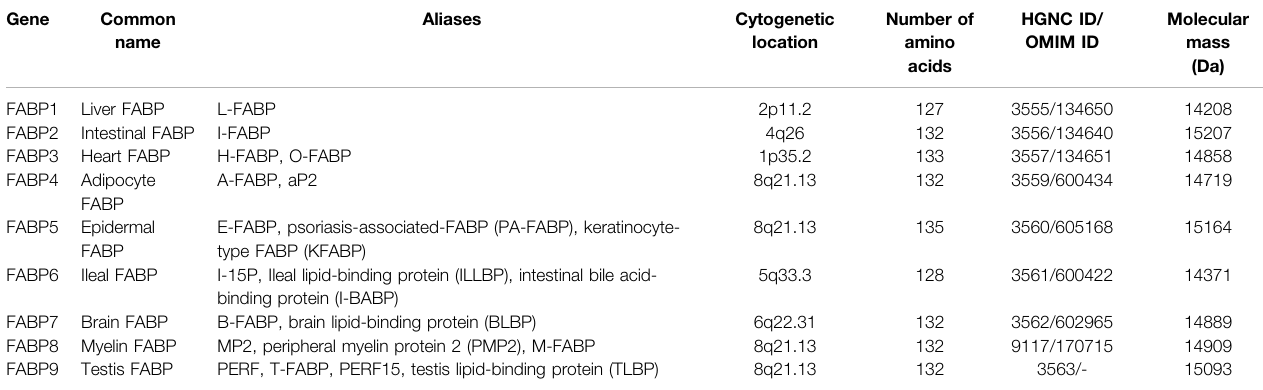
TABLE 1 | The features of FABP family